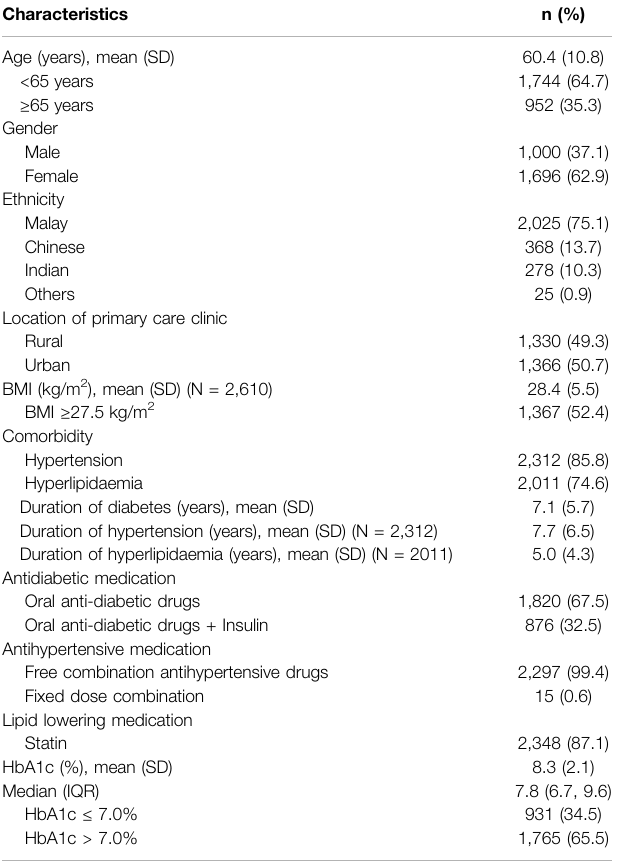
TABLE1| Demographiccharacteristicofstudycohortfrom “ EnPHC-Eva:Facility ” Malaysia, 2018-2019 (N = 2,696).